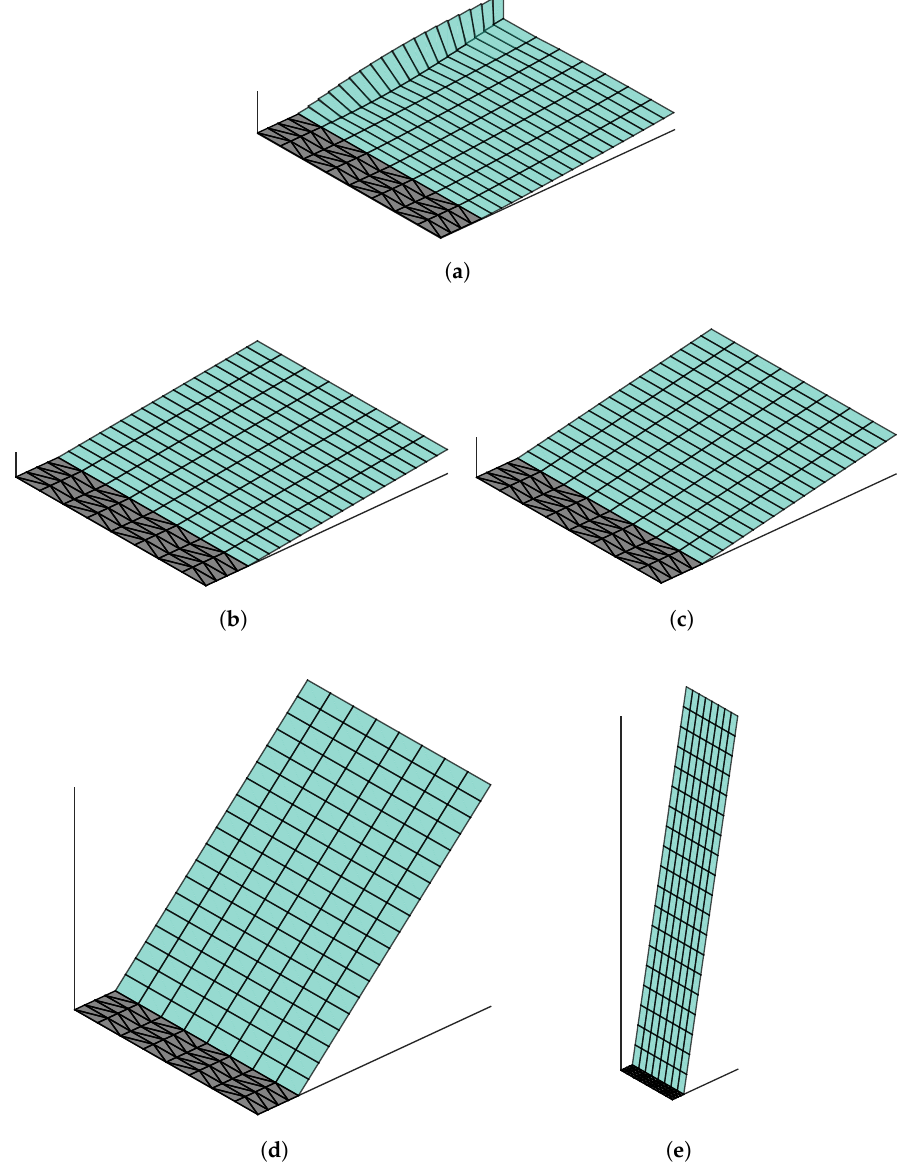
Figure 7. Wake shapes analysed on a rectangular wing with an aspect ratio of 10 at an angle of attack of six degrees [5]. ( a ) Relaxed (force-free); ( b ) freestream fixed (drag-free, angle of attack +6 degrees); ( c ) prescribed to +10 degrees; ( d ) prescribed to +45 degrees; ( e ) prescribed to +80